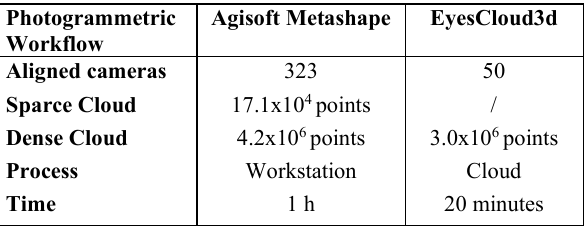
Table 1 . Software data